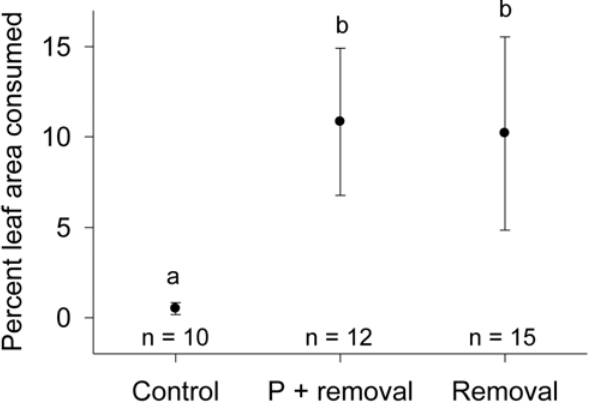
Figure 3. Field fertilization and competitor removal experi- ment. Percent leaf area consumed by gelechiid leaf-tiers (mean 6 SE) is used as an index of survival and growth on plants with competitors removed the previous summer and competitors removed + P fertilization. Survival is almost 0 on plants with neighbors. Treatments not sharing a letter (above error bars) are significantly different ( P =0.01).